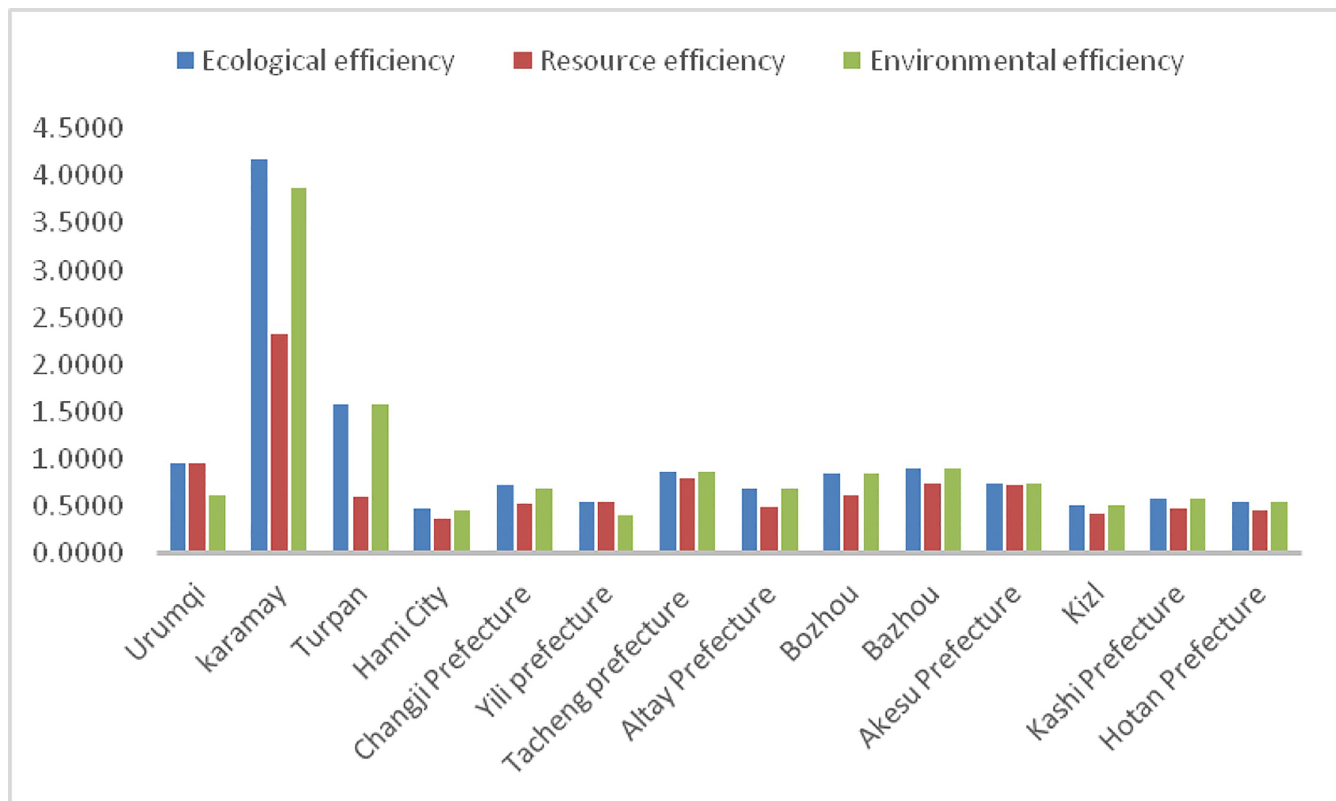
Fig 6. Comparison of ecological efficiency, resource efficiency, and environmental efficiency among 14 prefectures.